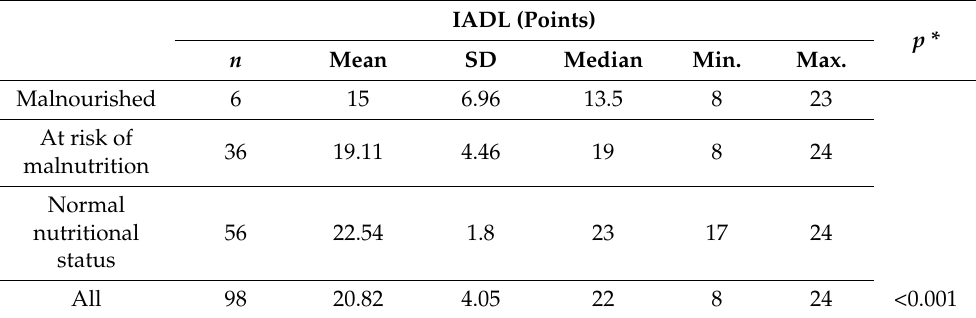
Table 3. Ability to perform instrumental activities of daily living by nutritional